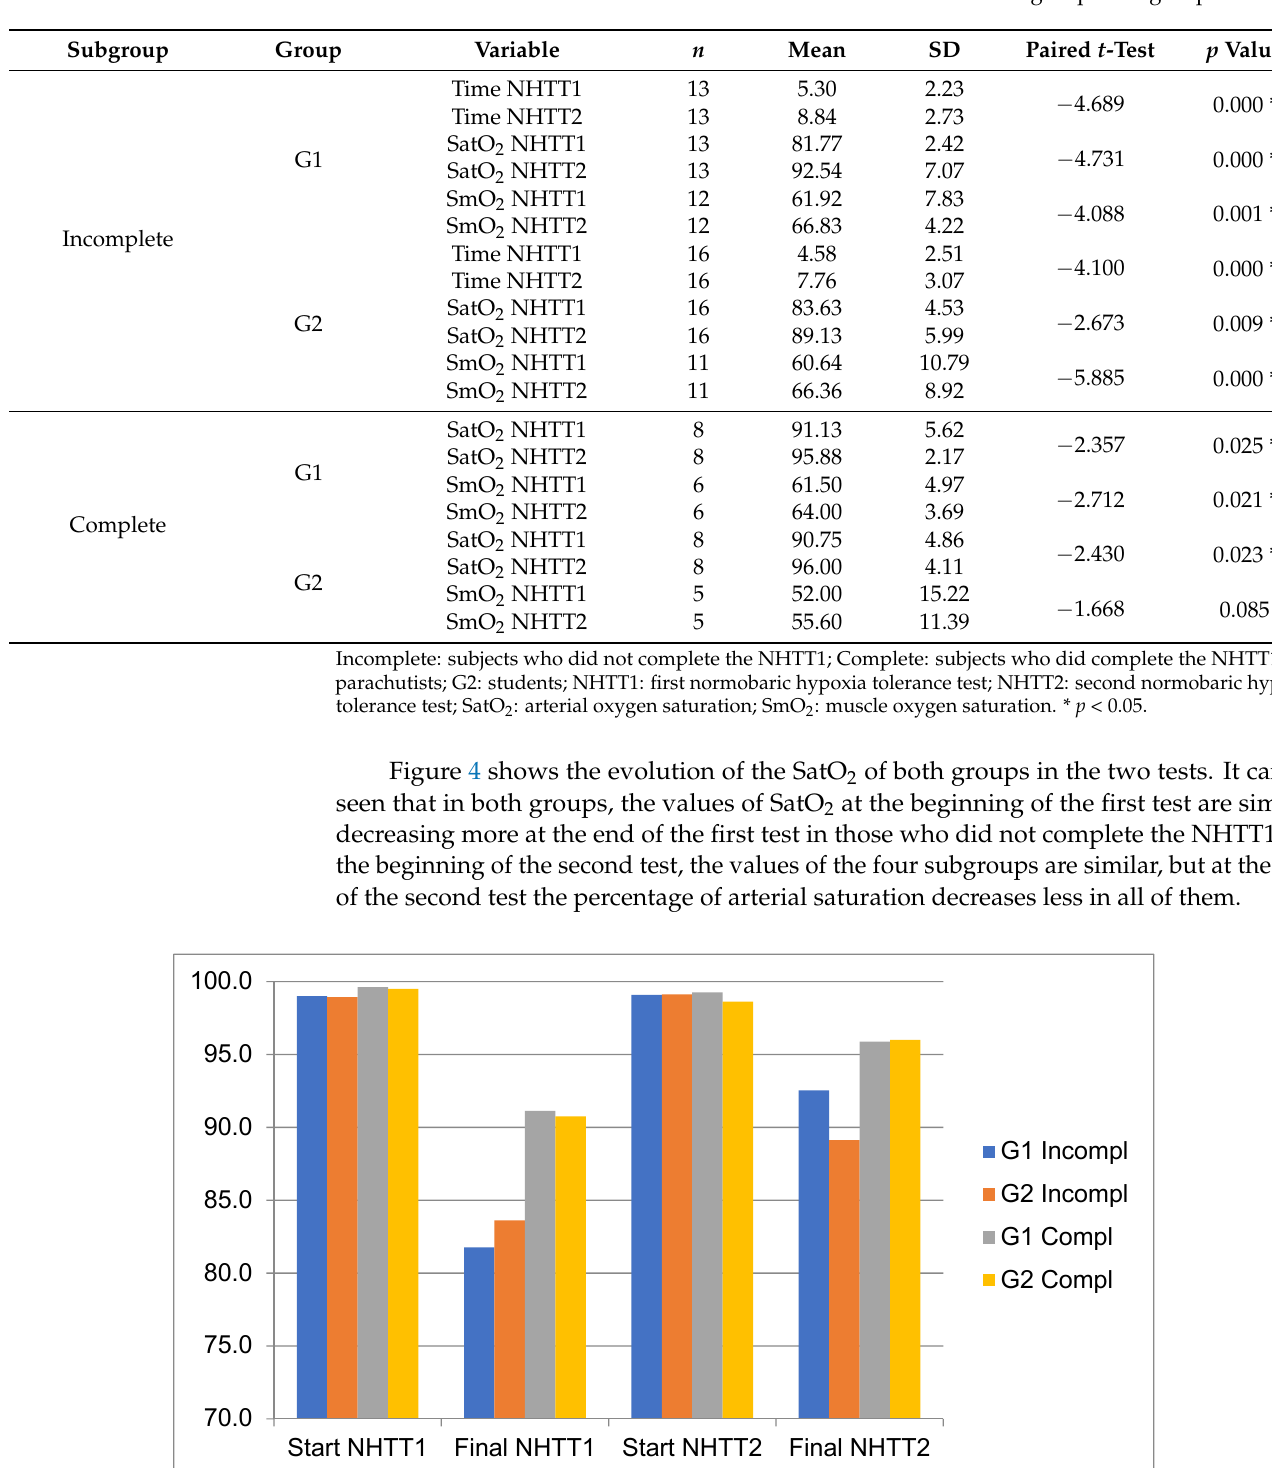
Table 7. Differences between the first and second test divided into subgroups and groups.